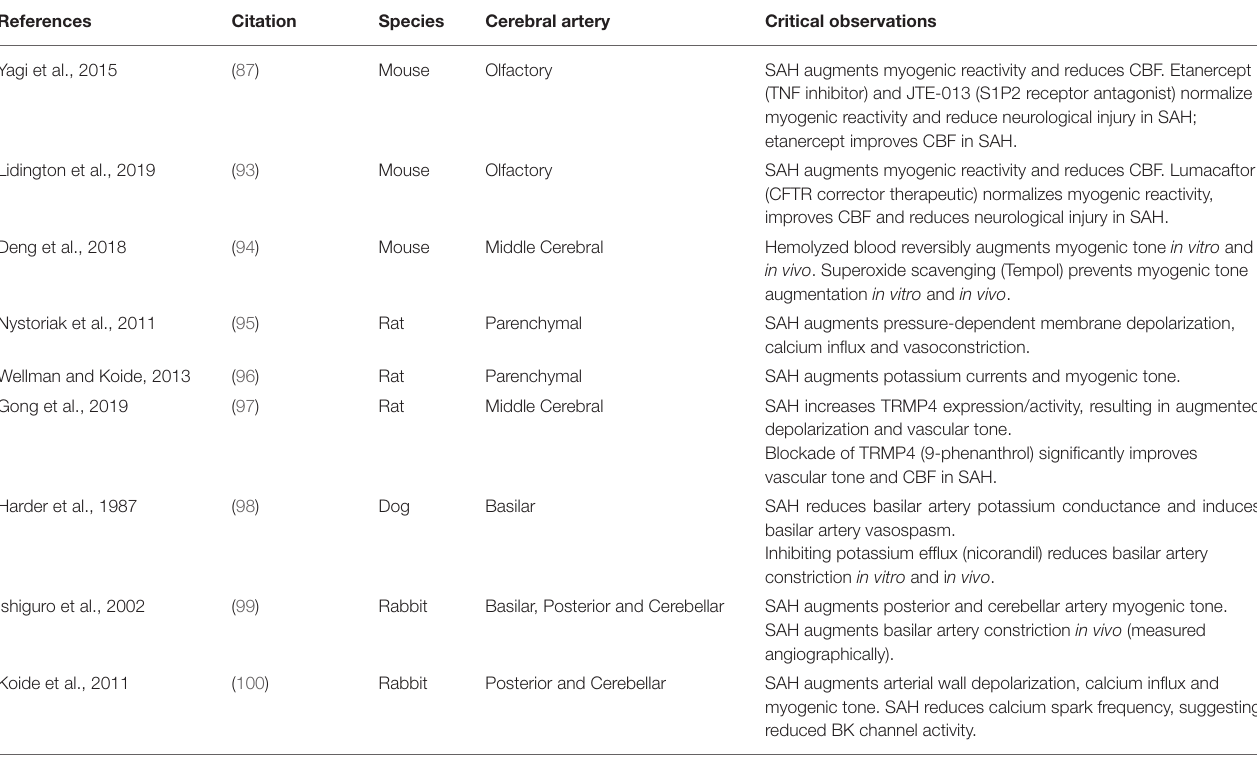
TABLE 1 | Research studies utilizing pressure myography to assess the effect of experimental subarachnoid hemorrhage on myogenic reactivity.